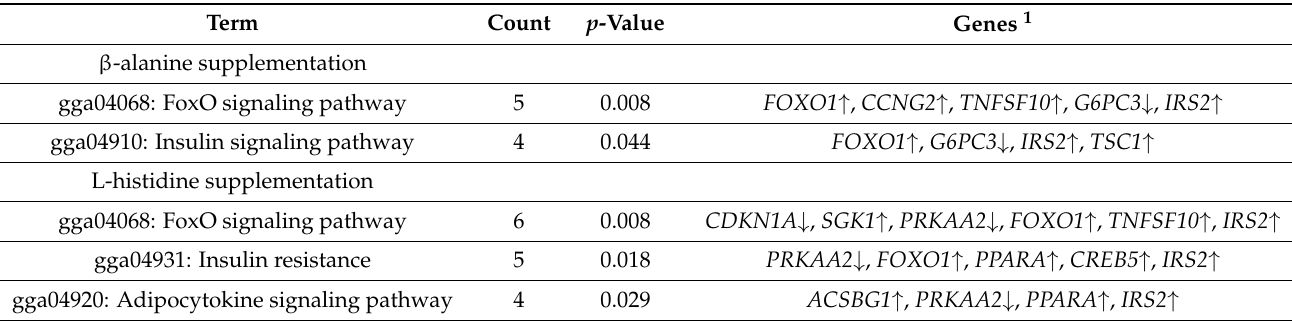
Table 4. Significantly enriched KEGG pathway in the β -alanine or L-histidine supplementation groups compared to the non-supplemented